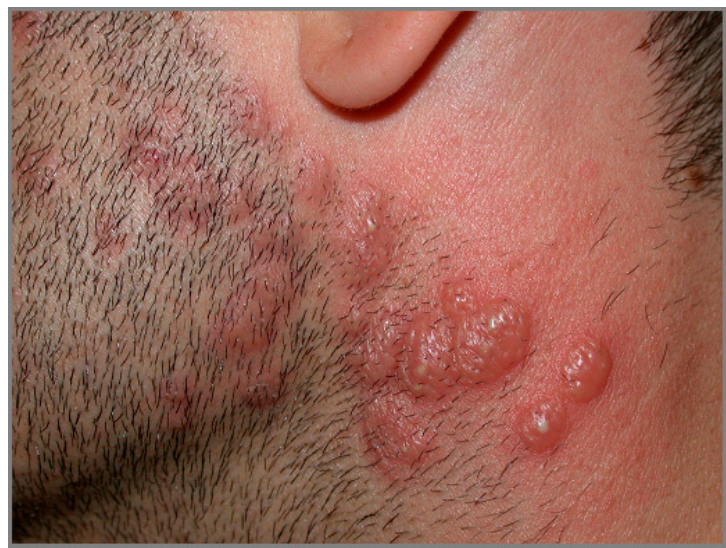
Figure 7. Tender erythematous papules and nodules associated with pseudovesiculation and pustules on head and neck in a man affected by Sweet syndrome.